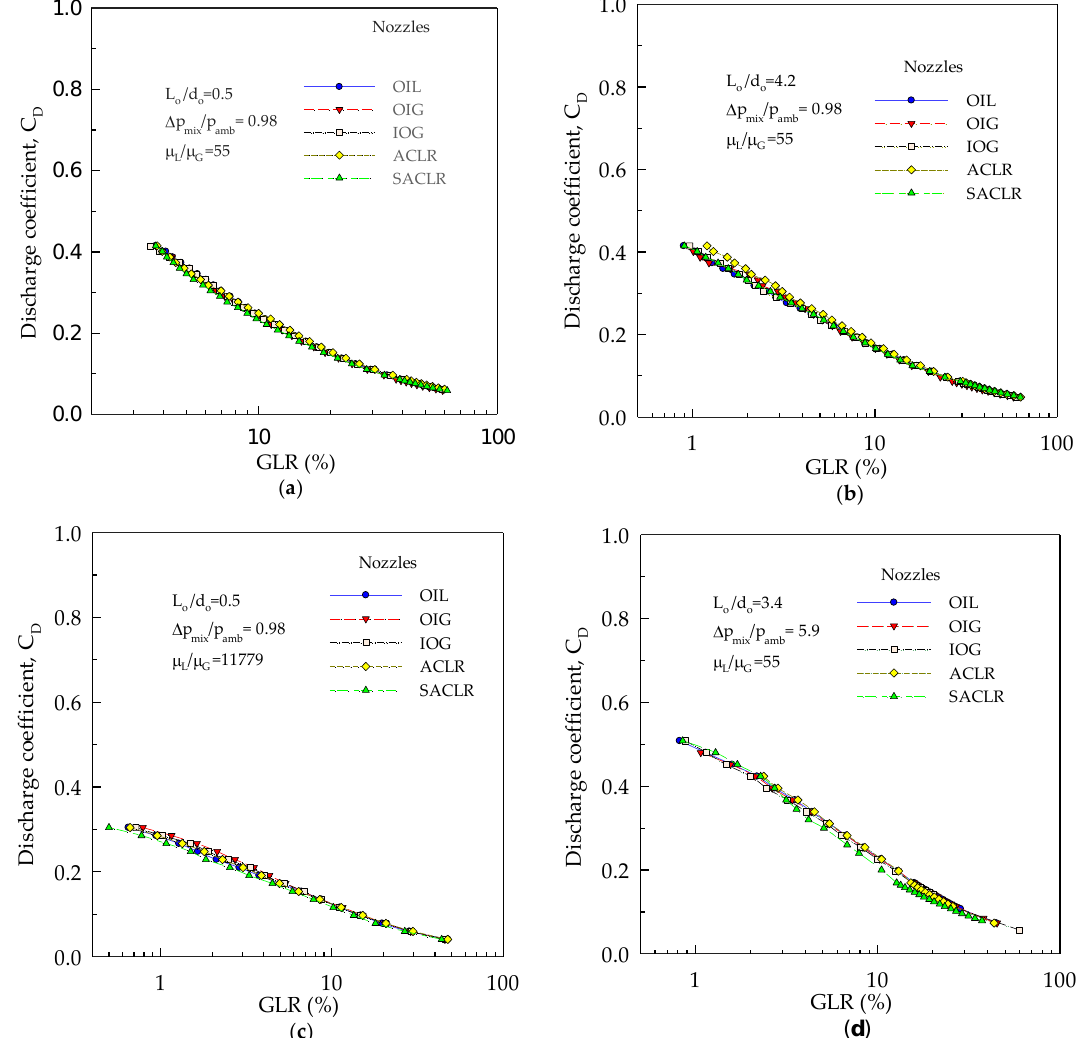
Figure 9. The e ff ect of the mixing method on C D at di ff erent conditions: ( a ) low values of all parameters; Figure 9. The effect of the mixing method on C D at different conditions: ( a ) low values of all ( b ) high L o / d o value; ( c ) high µ L / µ G value; ( d ) high values of ∆ p mix / p amb and L o / d o parameters; ( b ) high L o /d o value; ( c ) high µ L /µ G value; ( d ) high value s of ∆p mix /p amb and L o /d o .